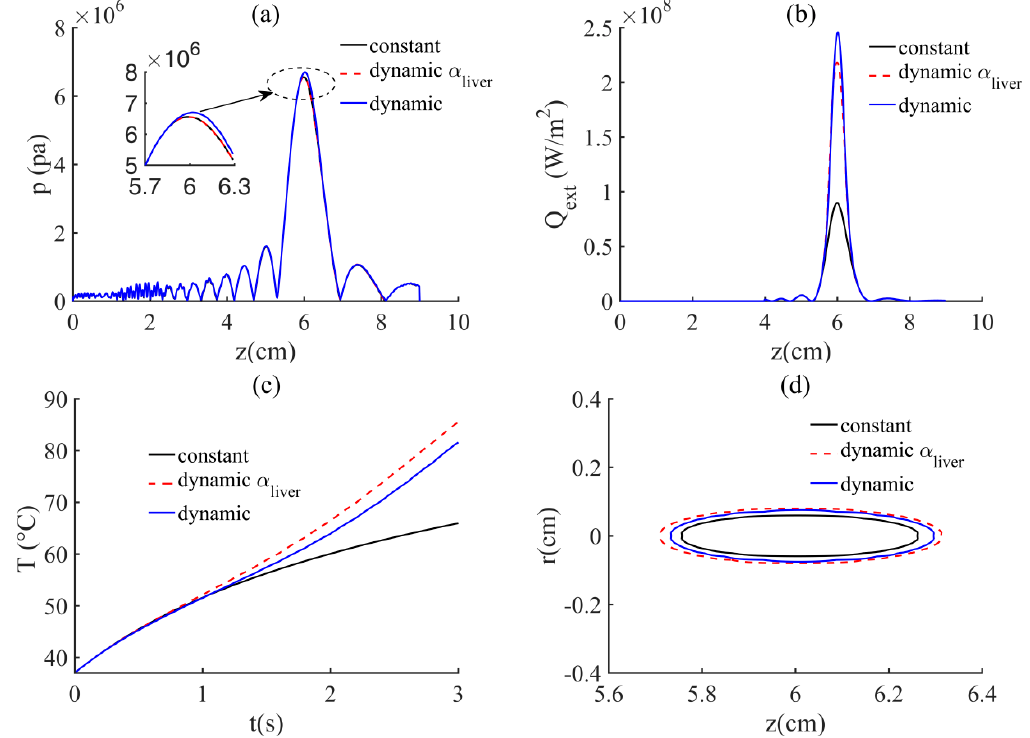
Figure 9. The effects of all of the dynamic tissue properties on: ( a ) p , ( b ) Q ext , ( c ) T at the ultrasonic focus, and ( d ) thermal damage zone.